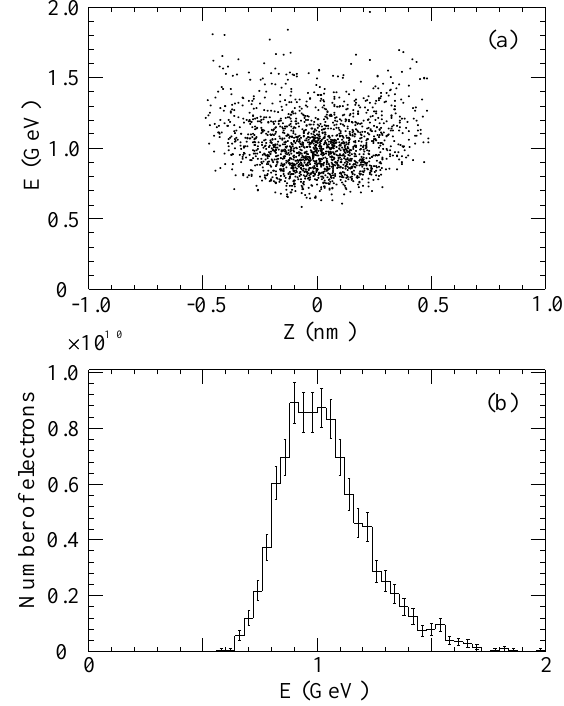
FIG. 1. The longitudinal distribution of the electrons. (a) The energy vs z . (b) The energy distribution of the electrons. The bin size is 40